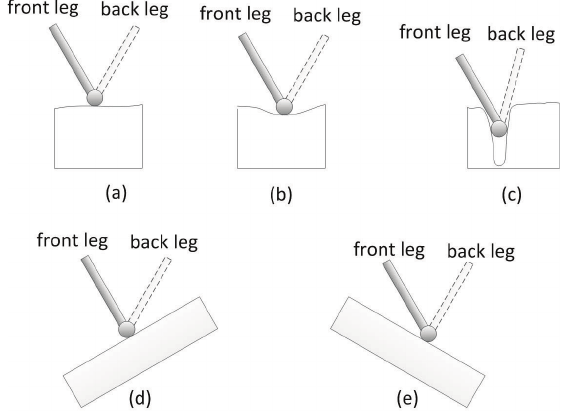
Figure 6. Several classical contact models between foot and terrain.( a ) shows the case of flat terrain; ( b ) shows the case of terrain with little curvature; ( c ) shows the case of terrain with large curvature; ( d , e ) show the preferences of selecting foothold for front and back leg,